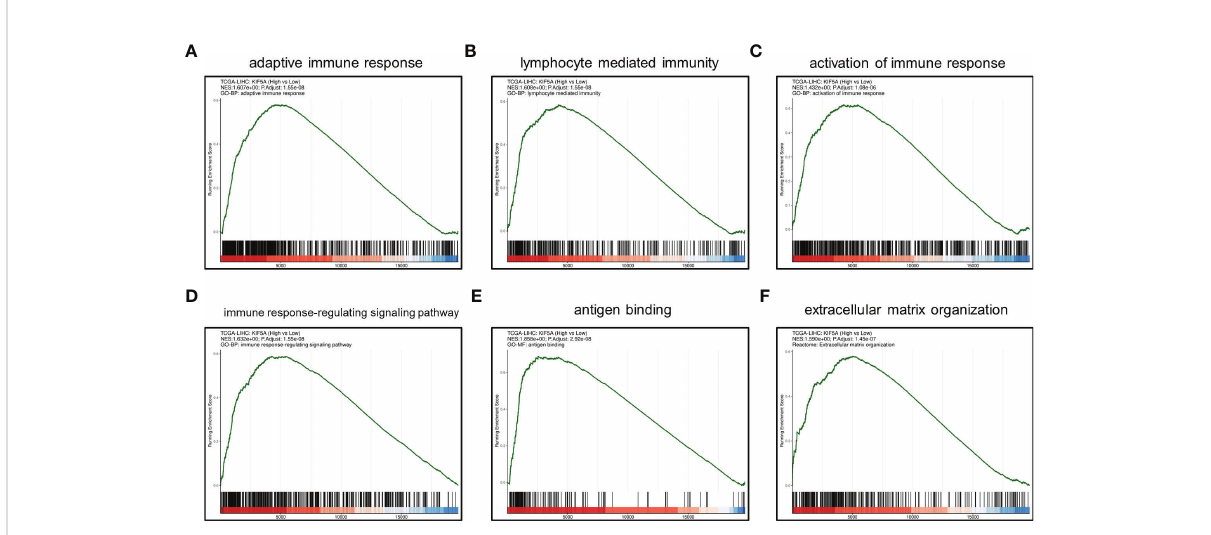
FIGURE 5 GSEA between KIF5A-high and low group. (A) adaptive immune response. (B) lymphocyte mediated immunity. (C) activation of immune response. (D) immune response-regulating signaling pathway. (E) antigen binding. (F) extracellular matrix organization.